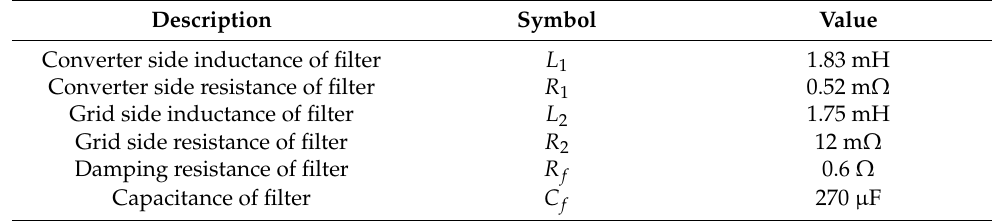
Table 1. System parameters.